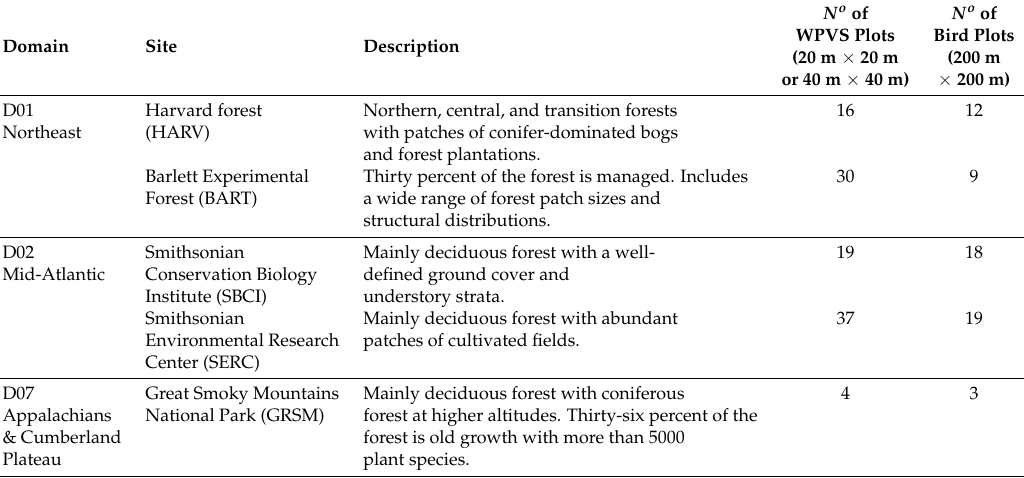
Table 1. Description of the National Ecological Observatory Network (NEON) sites with the number of bird and woody plant vegetation structure (WPVS) plots we used for each